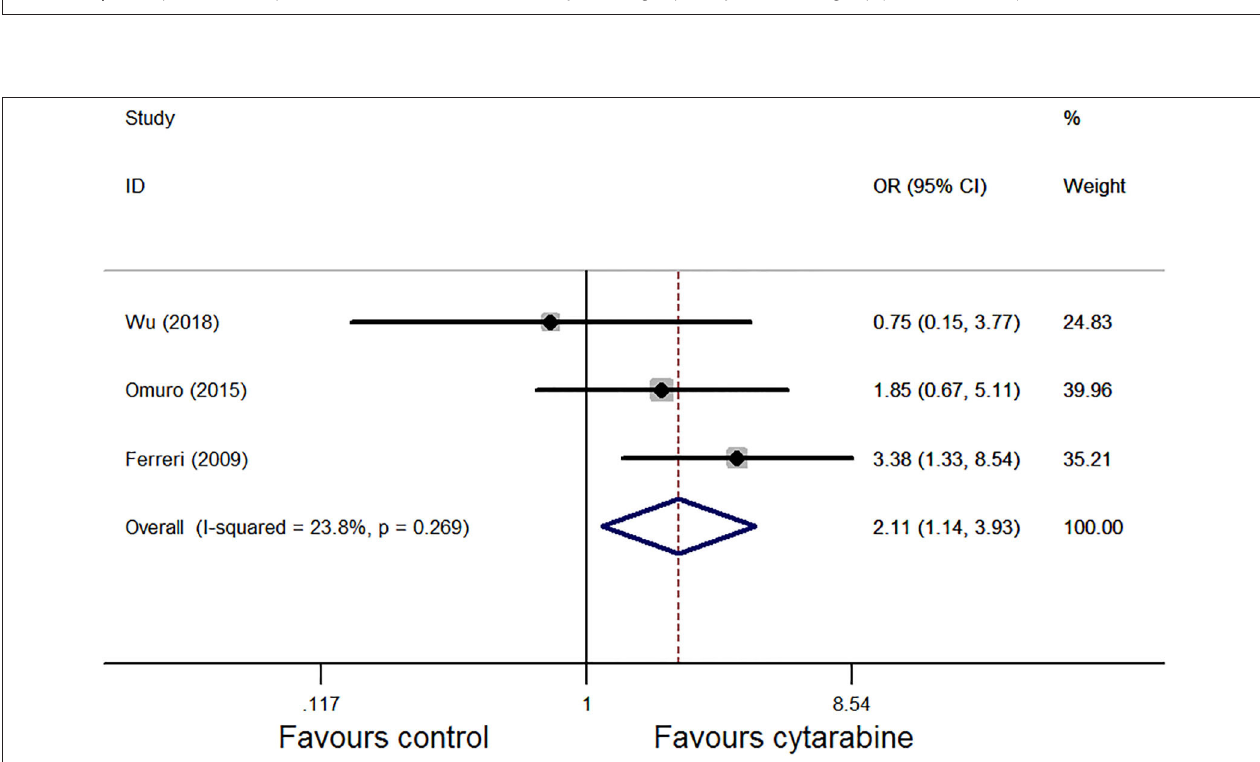
Frontiers in Oncology | www.frontiersin.org